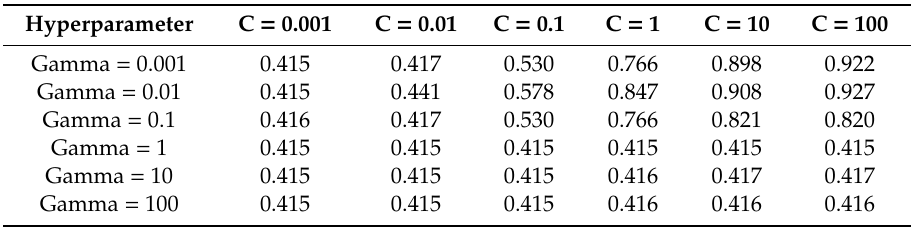
Table 5. Accuracy by SVM